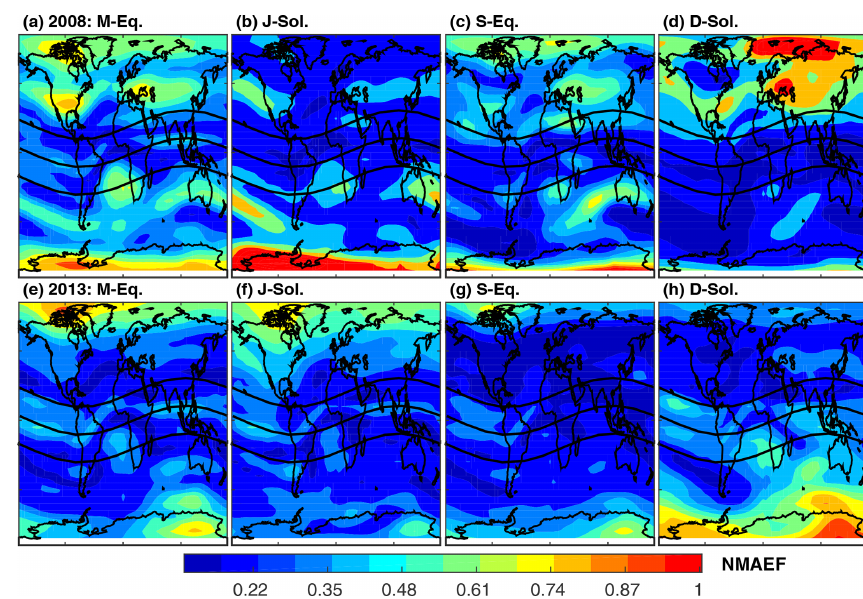
Figure 11. The same as Fig. 9 but for